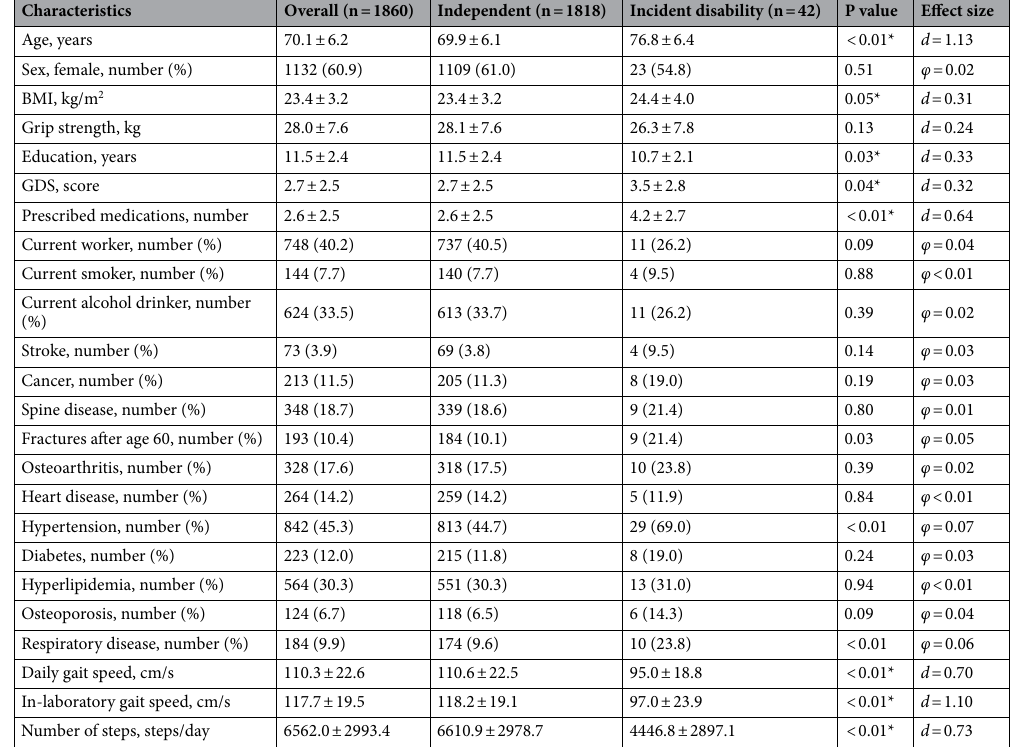
Table 1. Gait parameters and baseline characteristics of participants by incidence of disability during the two years after baseline assessment. Data are shown as means ± SDs. Unpaired t tests or chi-square tests were conducted between groups. BMI = body mass index; GDS = geriatric depression scale. * p < 0.05, d > 0.20, φ >